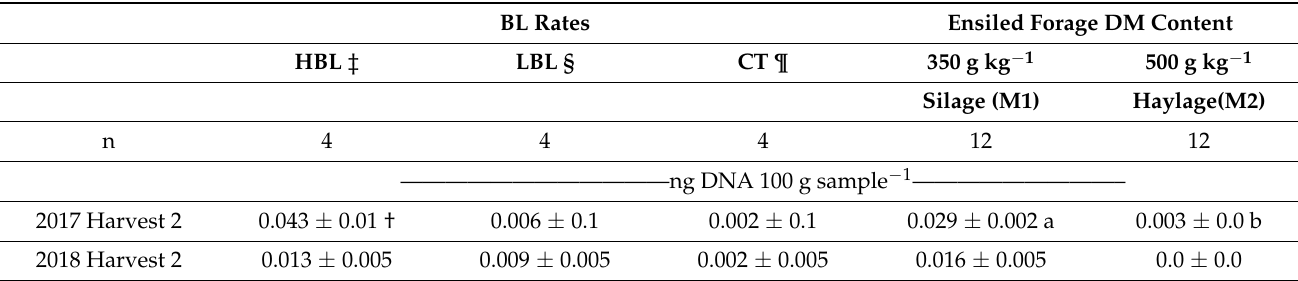
Table 7. Occurrence of Clostridium botulinum serovars A, B, E, and F in the ensiled products of second cut forage under the two ensiling forage dry matter (DM) regimes and BL